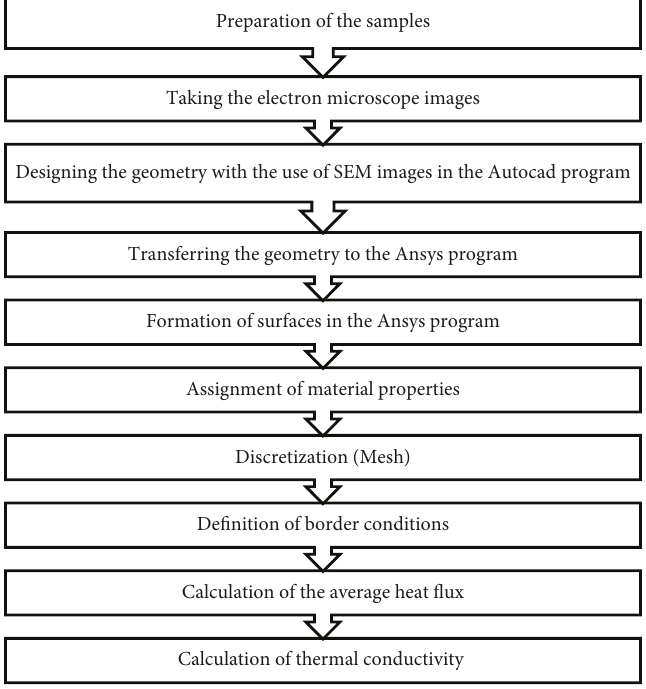
Figure 1: The fl ow chart for the numerical